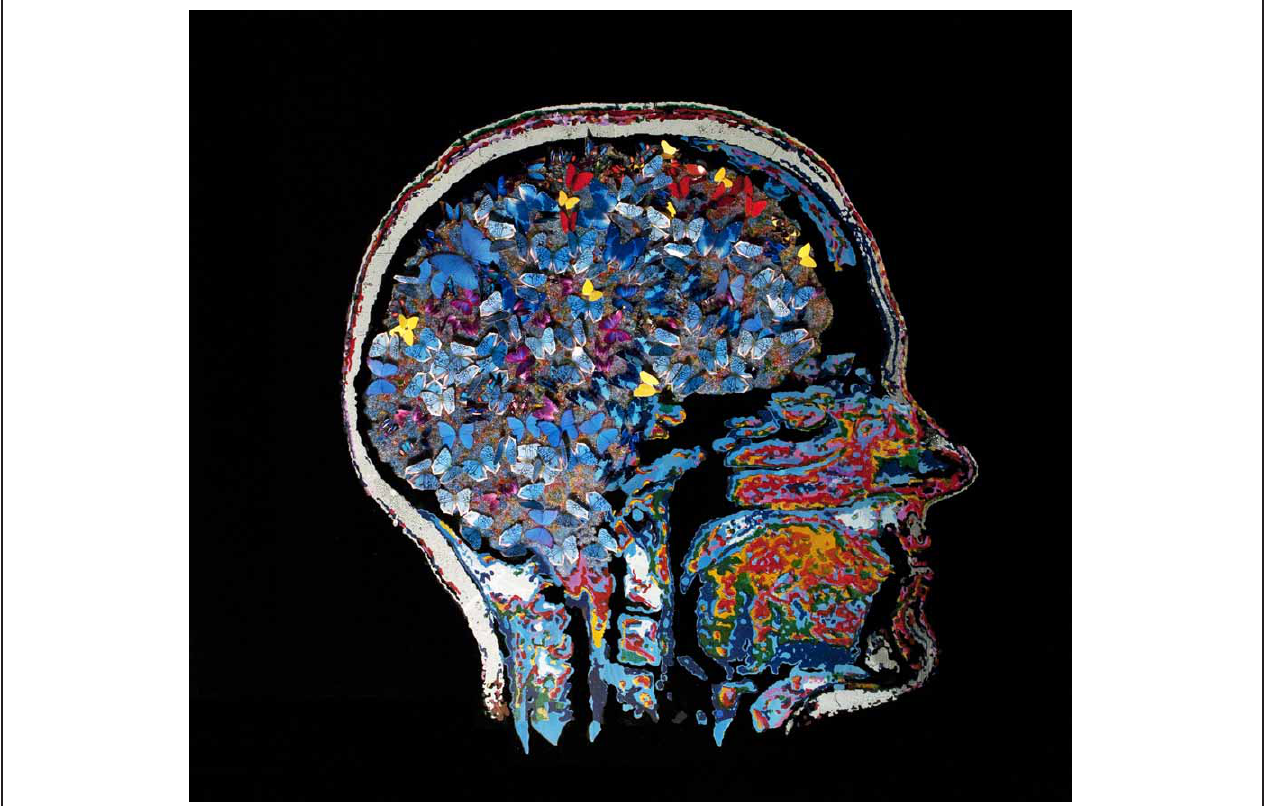
FIGURE 2 | PET soulbutterflies (2010). C-print and silkscreen on plexiglass. 1 . 20 × 1 .